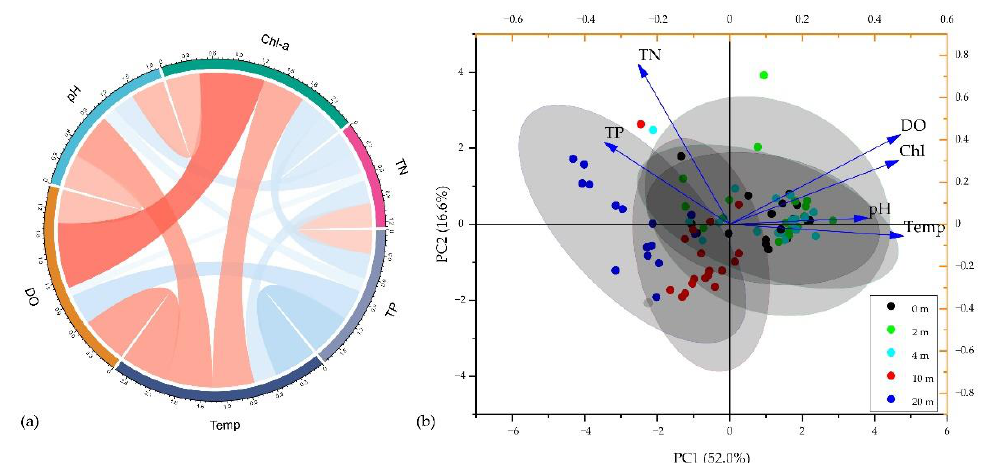
Figure 11. Correlation ( a ) and principal component ( b ) analysis of various water quality parameters. There were also differences in the TN and TP compositions at different sites and seasons (Figures 12 and 13).